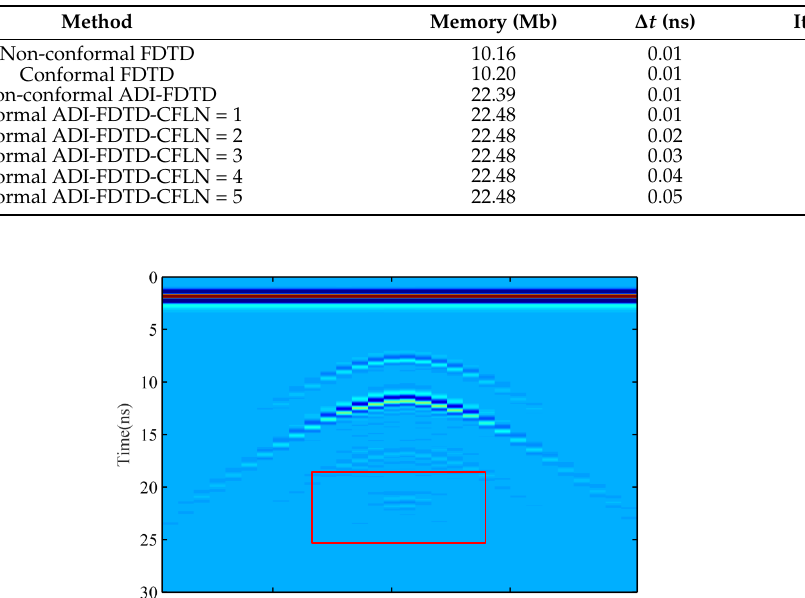
Figure 6. Comparison of E z field distribution between ADI−FDTD and FDTD simulation. Table 1. Computational resource usage of different methods.